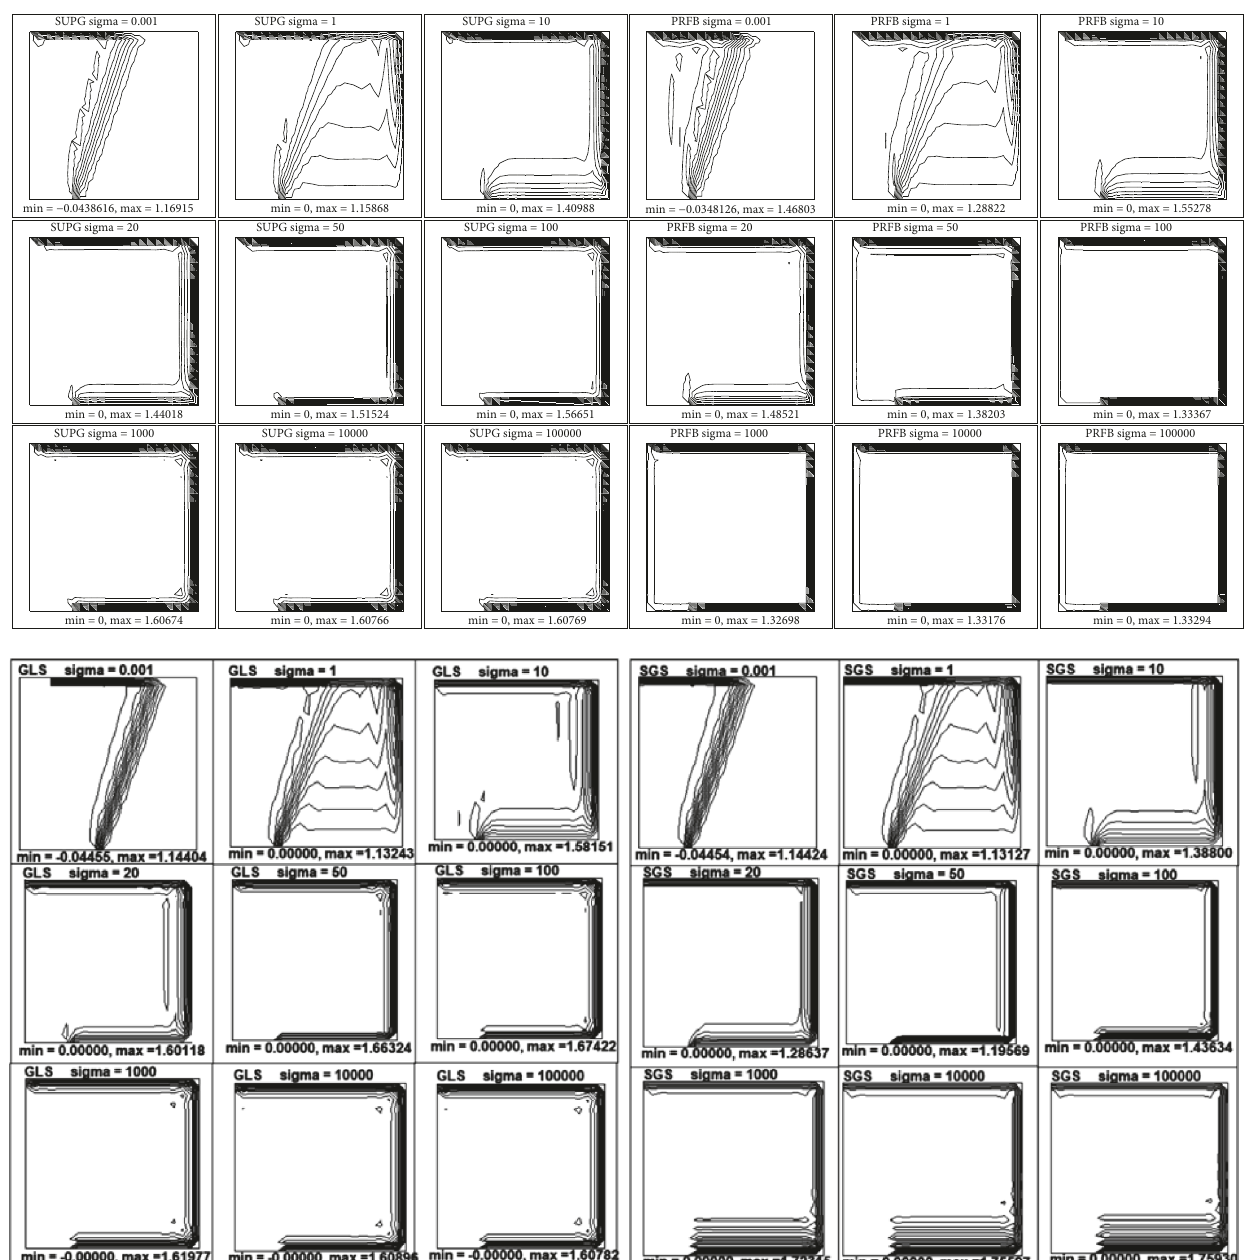
Figure 13: Corresponding contour plots.